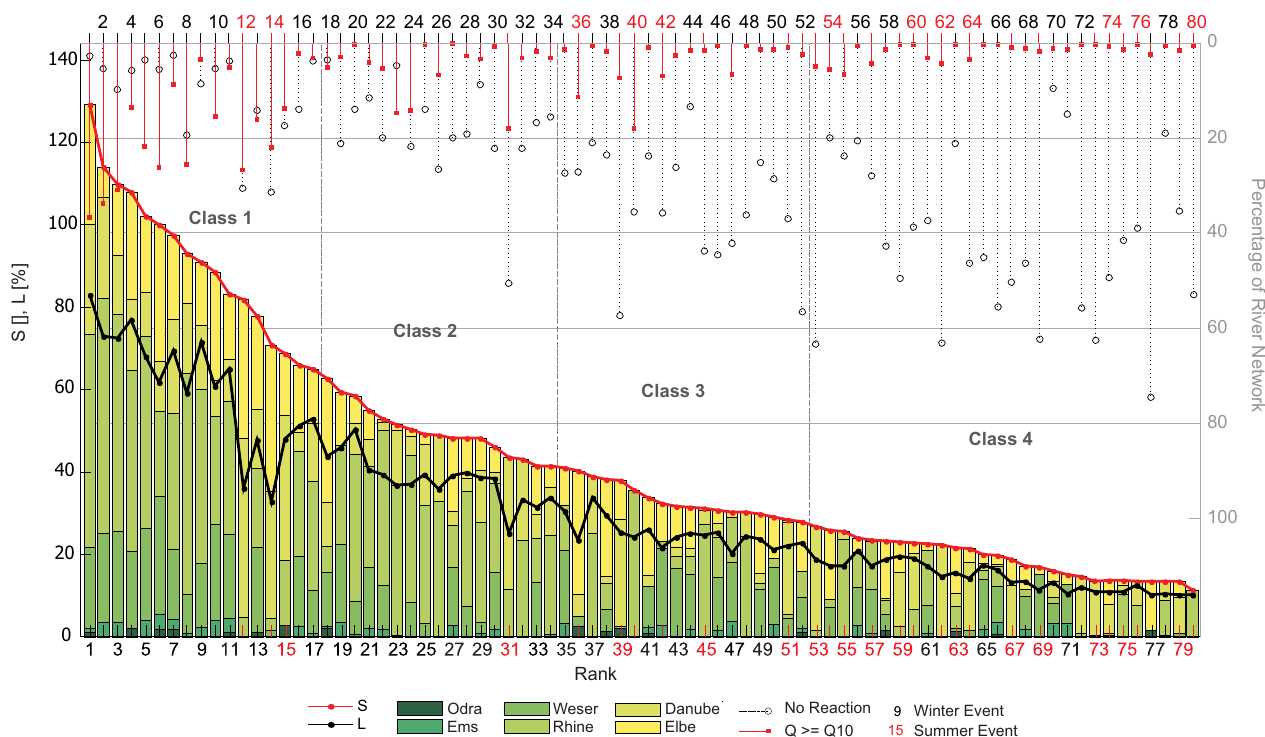
Fig. 4. Characteristics of the identified trans-basin events, ranked according to the weighted cumulative discharge index S (solid red line). The share each major basin (Odra, Ems, Weser, Danube, Rhine, Elbe) takes in the formation of the index S is indicated by the green to yellow shading. The percentage of the river network affected is given by L (solid black line). On the secondary x and y-axis both the number of gauges is given at which the 10-year flood was exceeded (dashed red stems) and the number of those that did not show any significant reaction during the event (dashed black stems). The grey dashed vertical lines indicate the approximate division of the event set into the 4 classes of spatial extent as given in Table